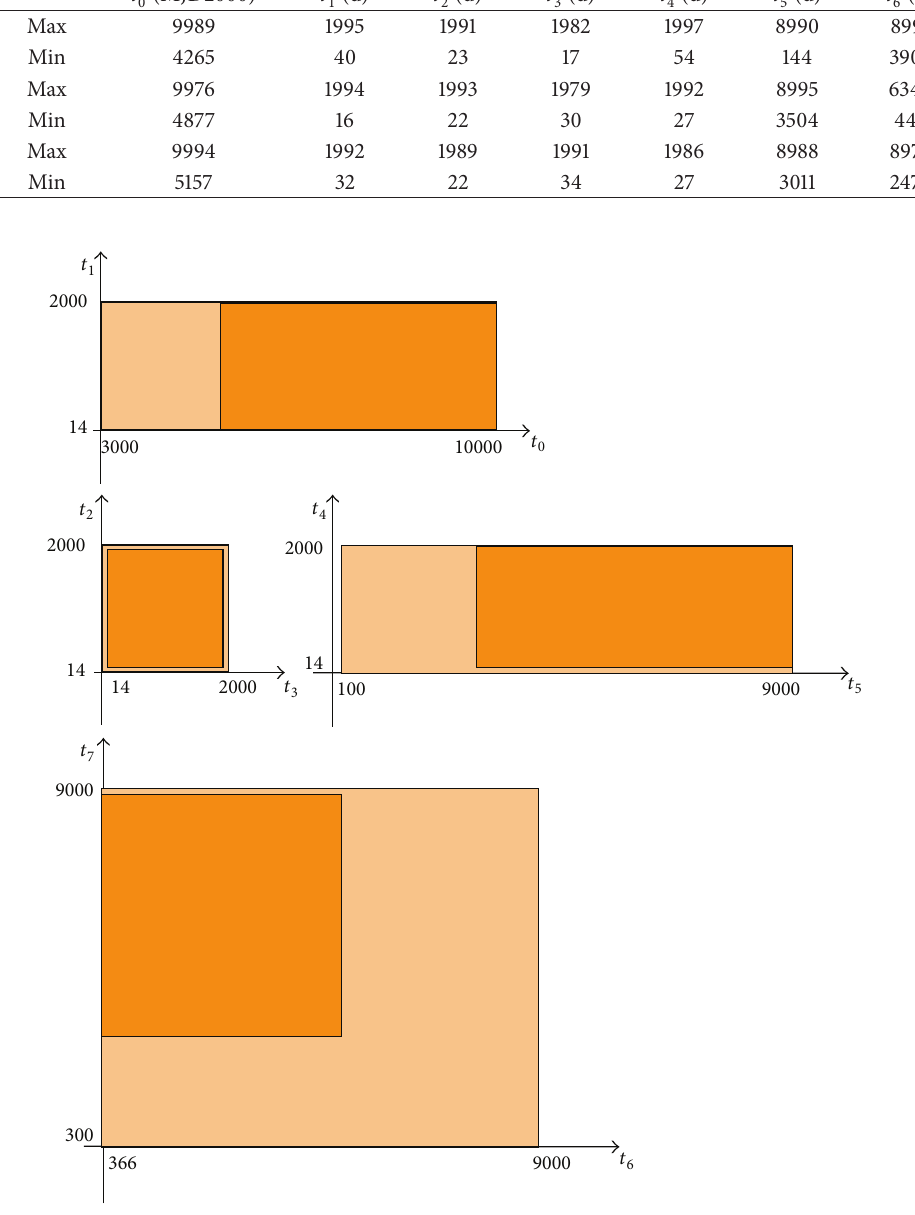
Figure 4: Community range in